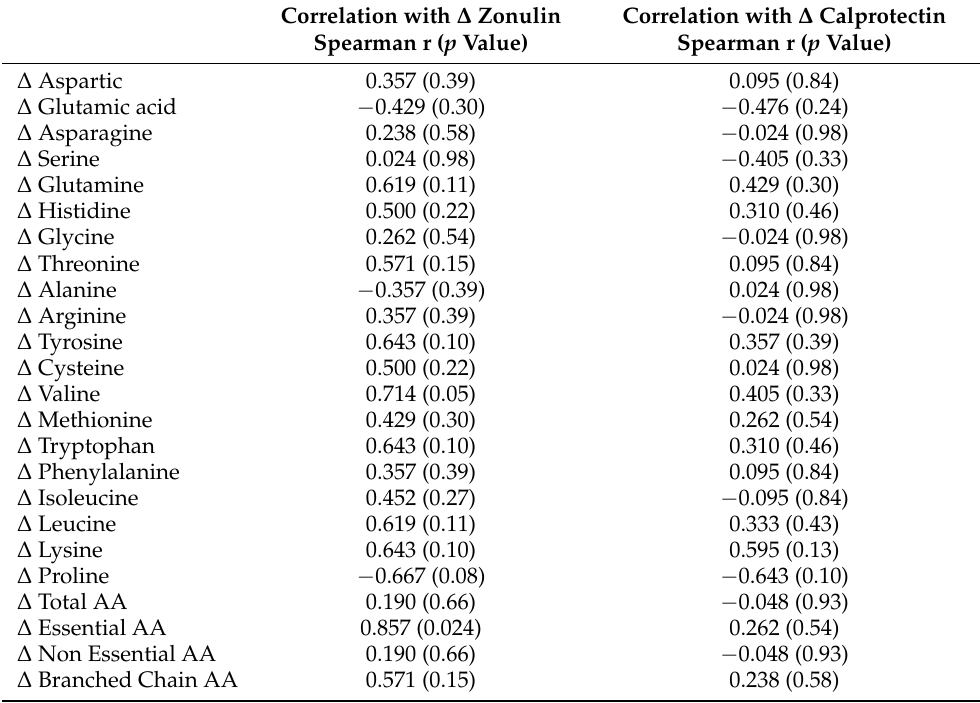
Reported p -values are from Wilcoxon signed rank test. Table 7. Association (Spearman r) between ∆ Zonulin (Zonulin after 6 months AA supplementation– baseline Zonulin, second column) and ∆ Calprotectin (Calprotectin after 6 months AA supplementation—baseline Calprotectin, third column) and ∆ plasma Amino Acid (AA) profile in Chronic Kidney